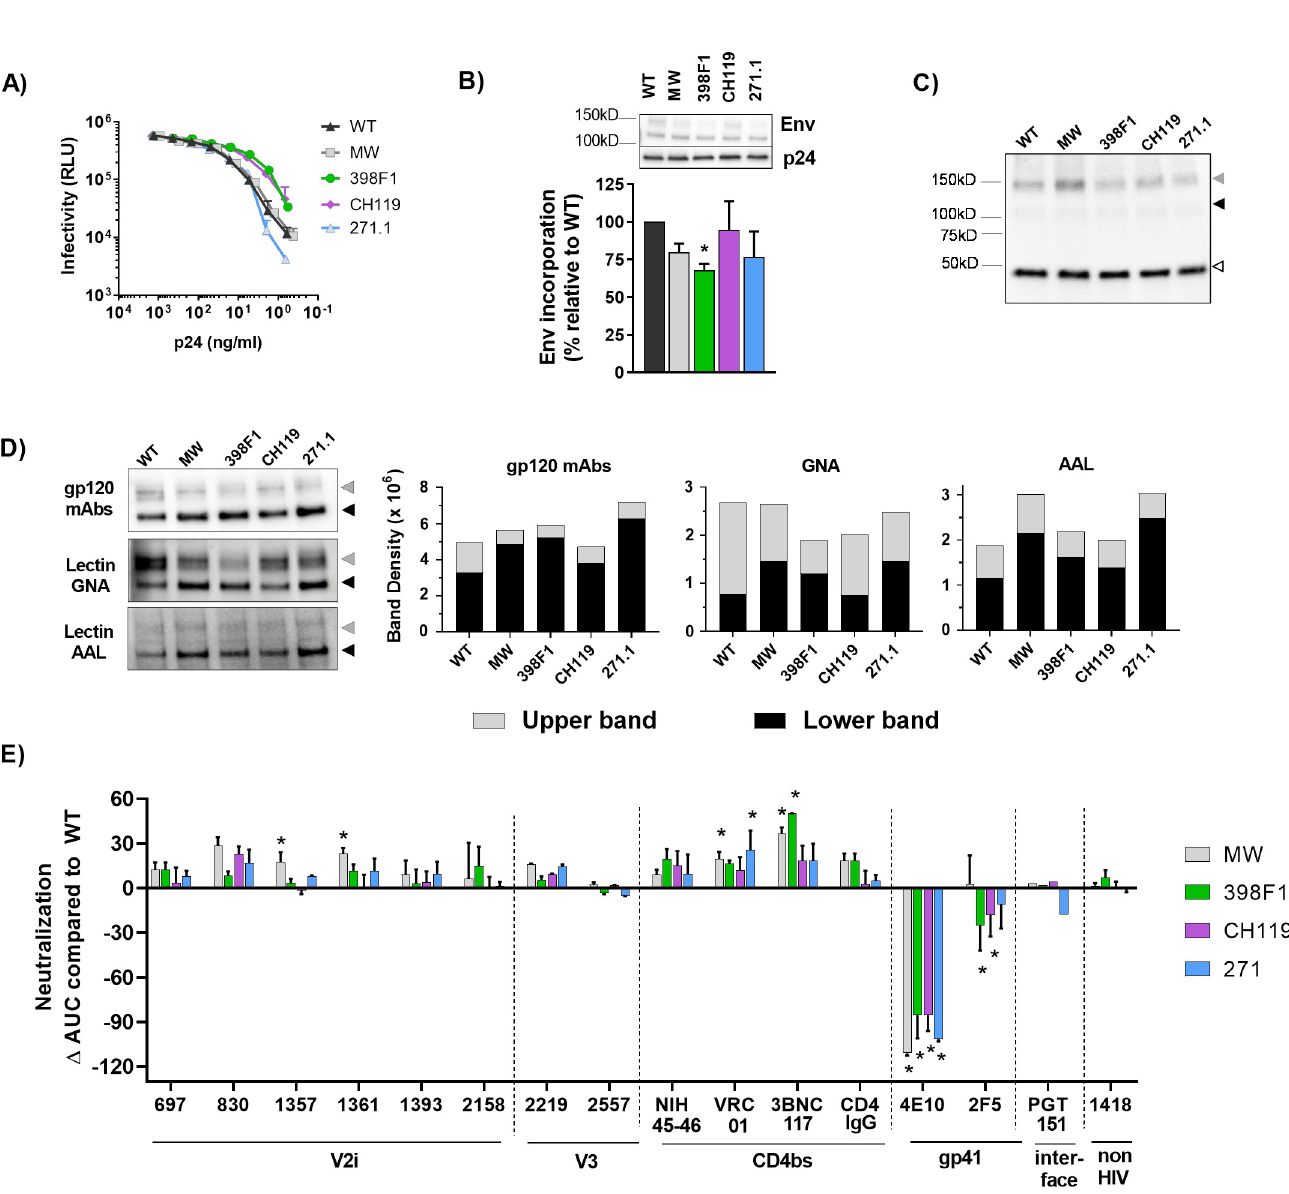
Fig 7. Effects of SP swap on SF162. (A) Infectivity of 293T-derived SF162 WT vs SP-swapped viruses in TZM.bl cells. (B) Measurement of Env incorporation by Western blot. � , p = 0.017 vs WT by unpaired t-test. (C) Western blot probed with gp41 MPER mAb 2F5. (D) Binding of Env from SF162 WT and SP-swapped viruses by gp120 mAbs and lectins (GNA and AAL) in Western blots. Densities of upper and lower Env bands are shown. (E) Changes in neutralization AUCs of SP-swapped vs WT viruses with different mAbs. Statistical analysis was performed on neutralization curves as in Fig 4A by 2-way ANOVA ( � p < 0.05). Gray, black and white triangles mark the positions of upper gp160, lower gp120, and gp41 Env bands, respectively.